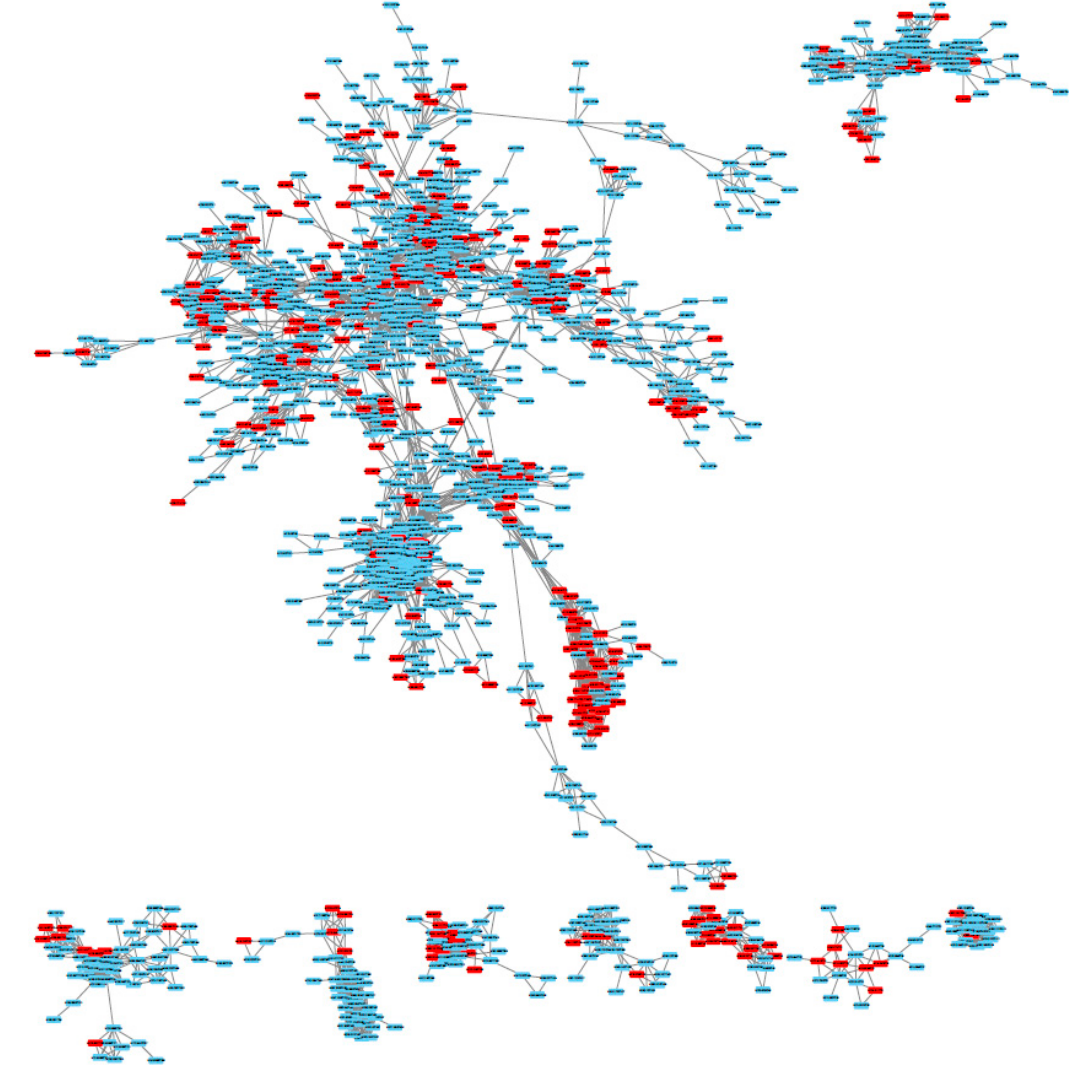
Figure 2. Correlation network of ions that have correlation coefficients above 0.75 in the Sacurine dataset. This network was obtained with Cytoscape using the *.sif output file of the ACorF tool. It represents groups containing more than 10 ions. Red features are identified as being redundant and tagged as deleted by the ACorF tool.